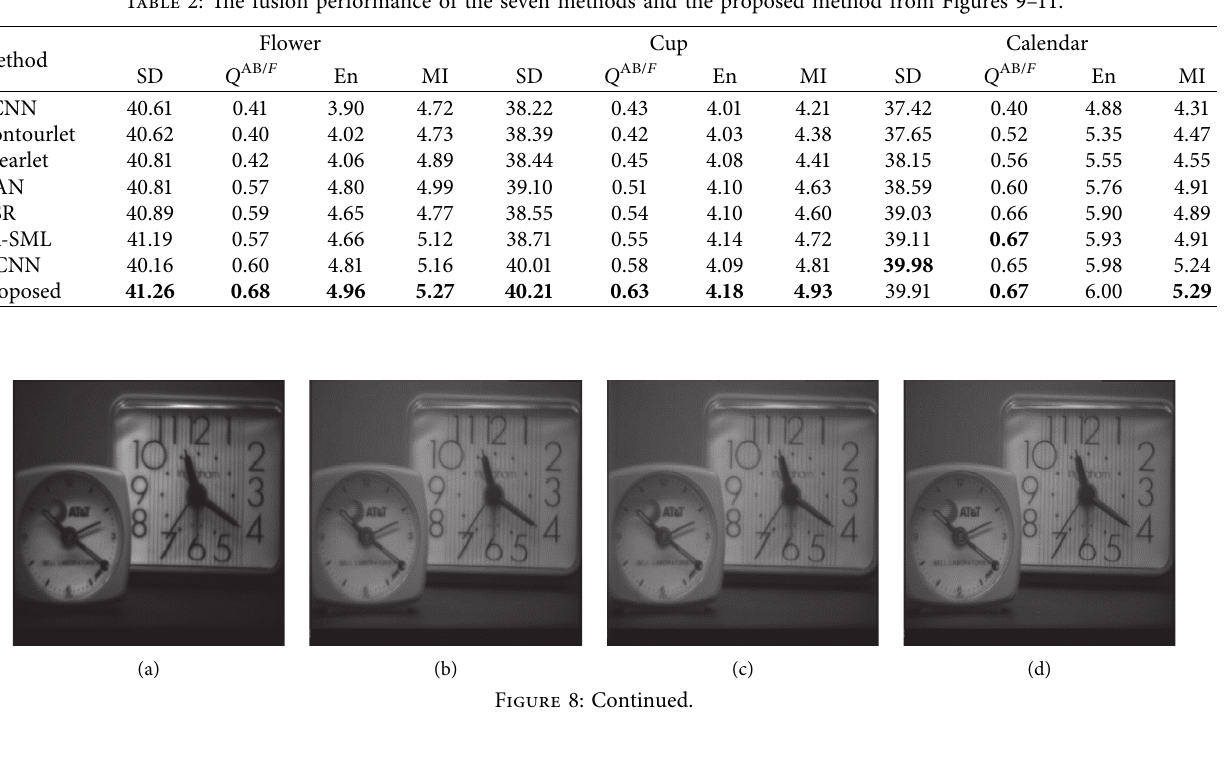
Table 2: The fusion performance of the seven methods and the proposed method from Figures